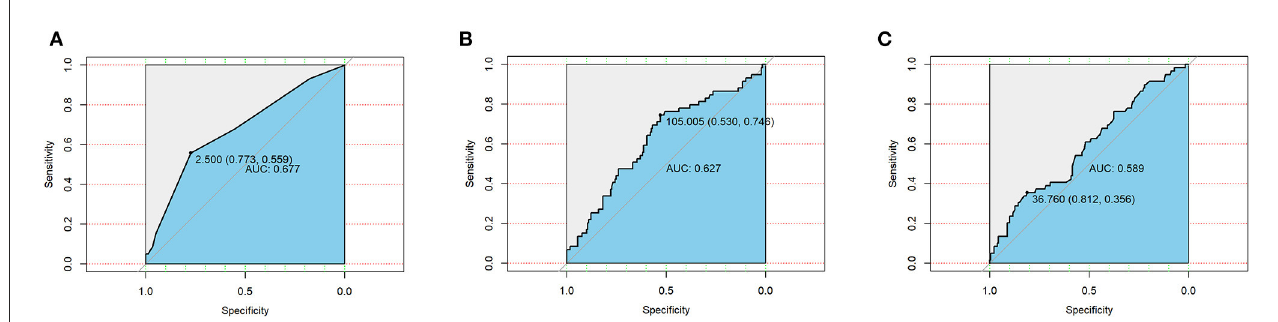
FIGURE1 Receiver operating curves (ROC) of three nutritional scoring systems CONUT (A) , GNRI (B) , and PNI (C) in postoperative complications in patients with bronchiectasis.